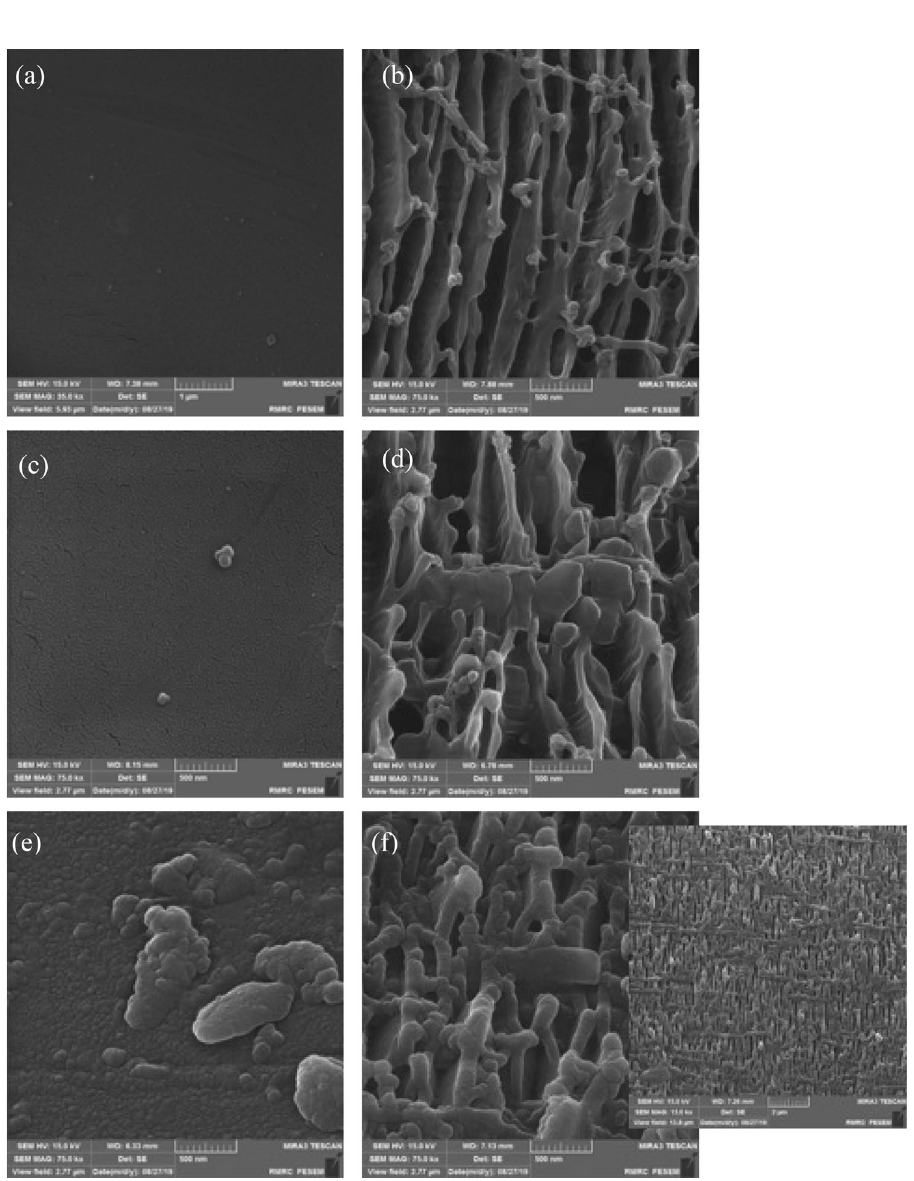
Figure 3. FE-SEM micrographs at × 75,000 magnification of ( a ) control PP mesh, ( b ) plasma-treated PP mesh, ( c ) BET loaded control PP mesh, ( d ) BET loaded plasma-treated PP mesh, ( e ) BET loaded plasma-polymerized PP mesh, ( f ) BET loaded plasma-treated and plasma polymerized PP mesh, with the corresponding magnification at ×